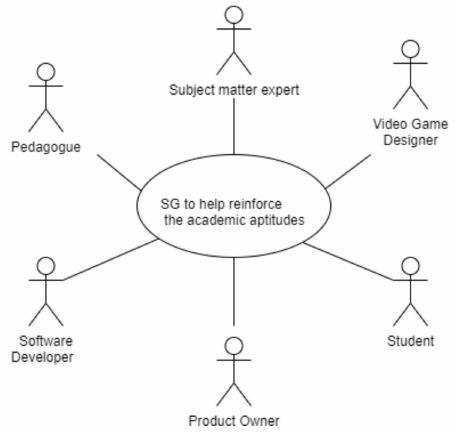
Figure 10. Identified Participants.